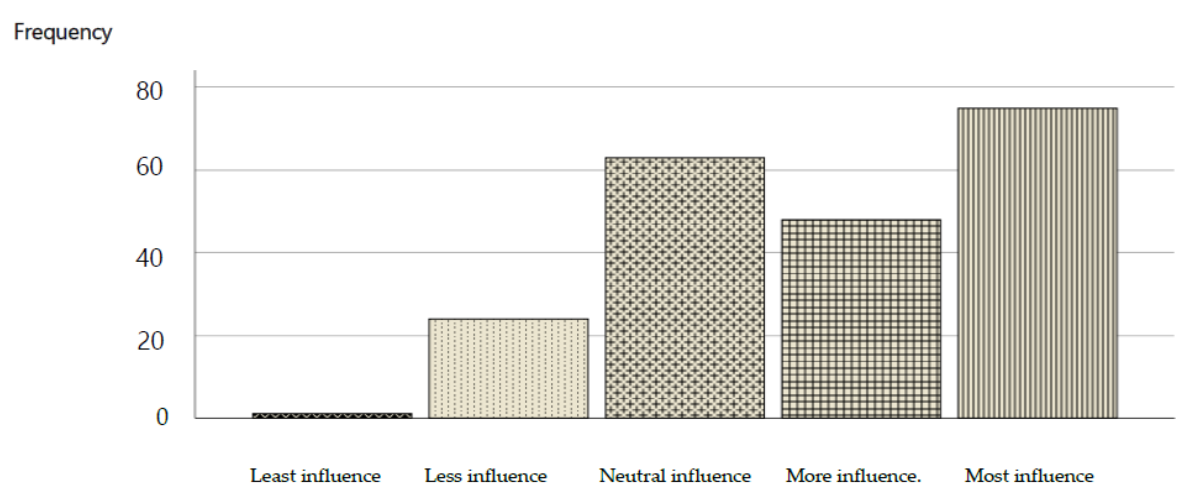
Figure 1. The “level of credibility” is given by students to e-resources recommended by faculty members. Table 6. Influence of online applications/animations on the students’ perceived academic performance.